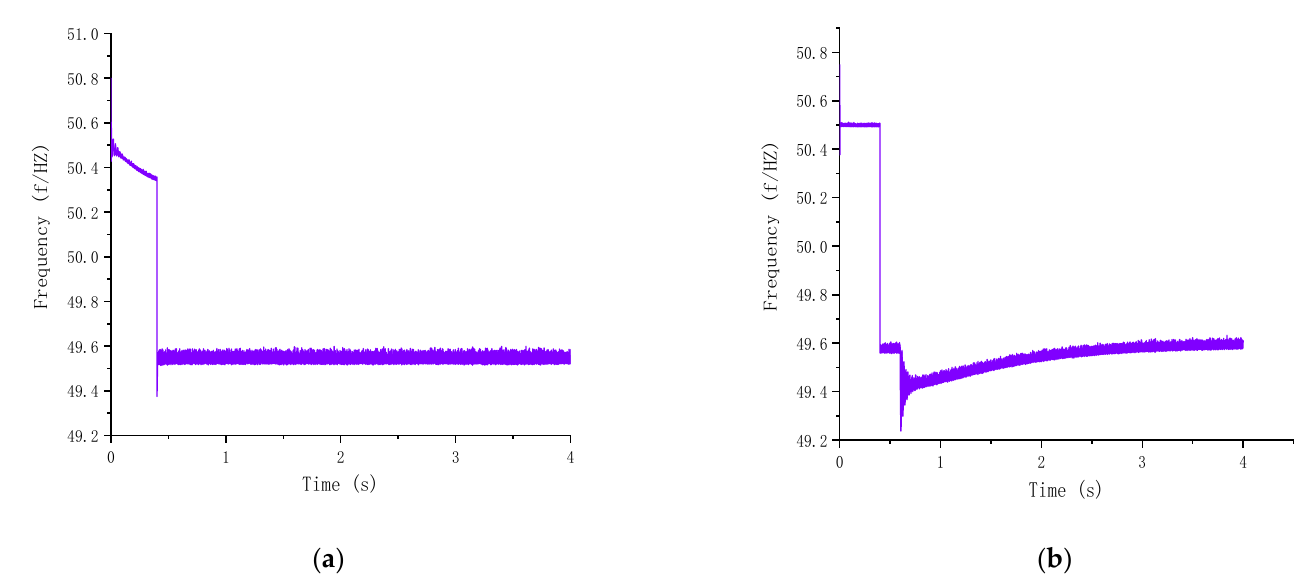
Figure 14. Parameter results of microgrid system under primary droop control ( a ) Frequency of access load 20 kw ( b ) Frequency of access load 25 kw.